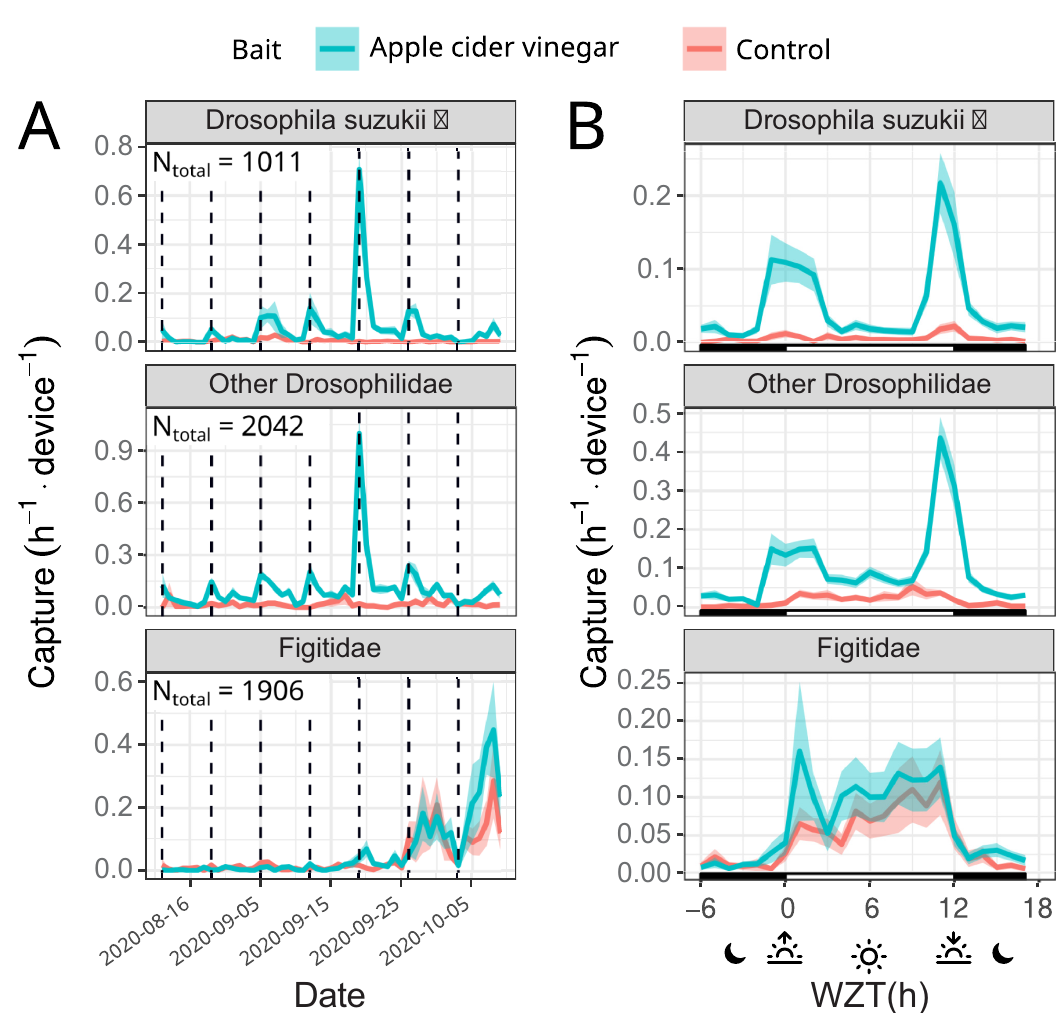
Fig 5. Sticky Pis can monitor spotted-wing drosophila diel activity in the field. We deployed 10 Sticky Pis in a blackberry field for 7 weeks and attached apple cider vinegar baits to half of them (blue versus red for unbaited control). This figure shows specifically the males Drosophila suzukii , the other Drosophilidae flies, and the Figitidae wasps. (A) Capture rate over time, averaged per day, showing the seasonal occurrence of insect populations. (B) Average capture rate over time of the day (note that time was transformed to compensate for changes in day length and onset—i.e., Warped ZT: 0 h and 12 h represent the sunset and sunrise, respectively, see Methods section). Both males D . suzukii and the other drosophilids were trapped predominantly on the baited devices. Both populations exhibit a crepuscular activity. In contrast, Figitidae wasps have a diurnal activity pattern and are unaffected by the bait. Error bars show standard errors across replicates (device × week). The underlying data for this figure can be found on figshare [20]. ZT, Zeitgeber